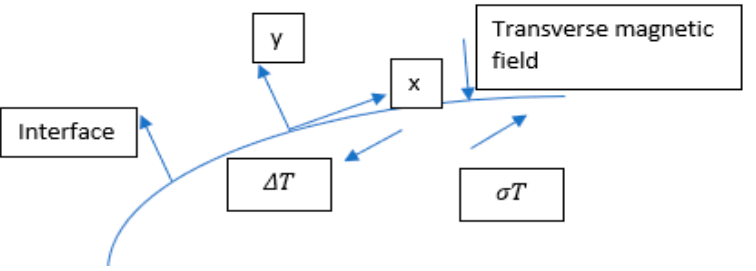
Figure 1. The schematic of the model. Processes 2020 , 8 , x FOR PEER REVIEW